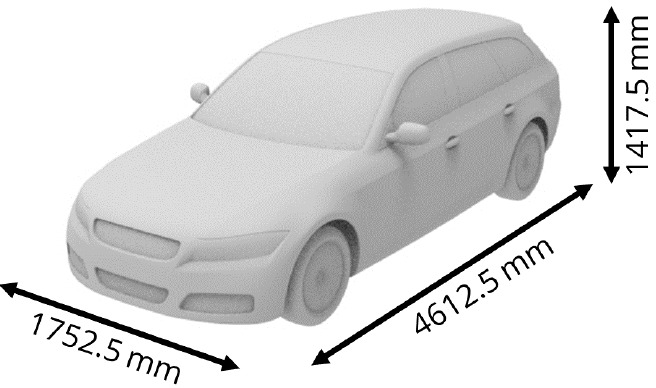
Figure 1. DrivAer model in full-scale.